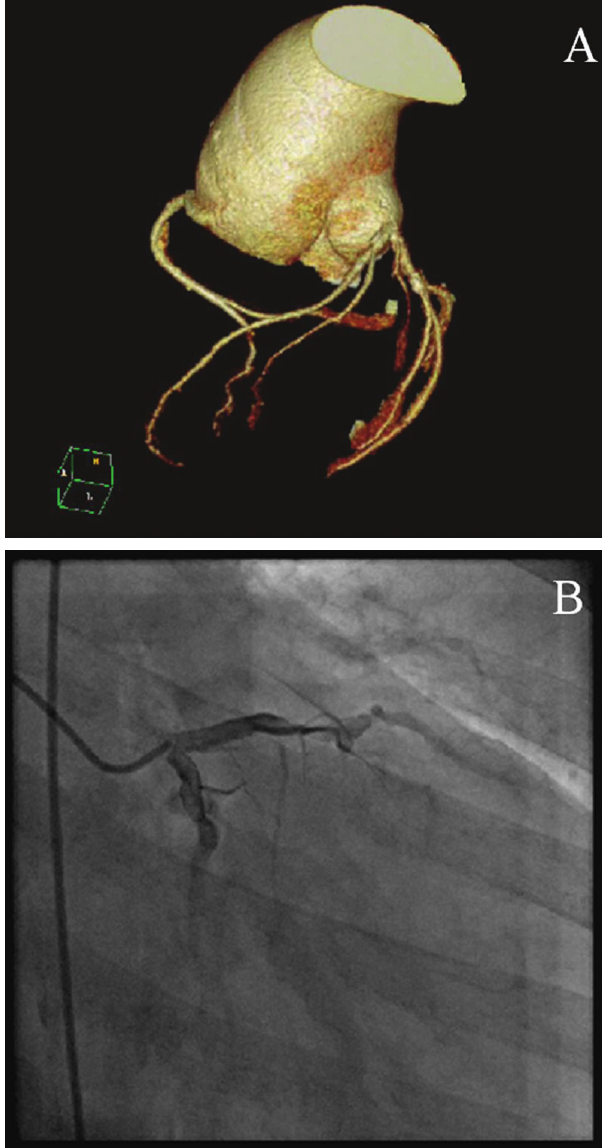
Figure 3 - Images showing the absence of the left main coronary artery. (A) A 3-D reconstruction of a computerized tomography scan of the heart of a 64-year-old male patient with an ascending aortic aneurysm and moderate-to- severe aortic regurgitation with a tricuspid aortic valve. (B) A right anterior oblique view of the coronary angiogram of a 75-year-old male patient with a chronic type A aortic dissection and a tricuspid aortic valve.